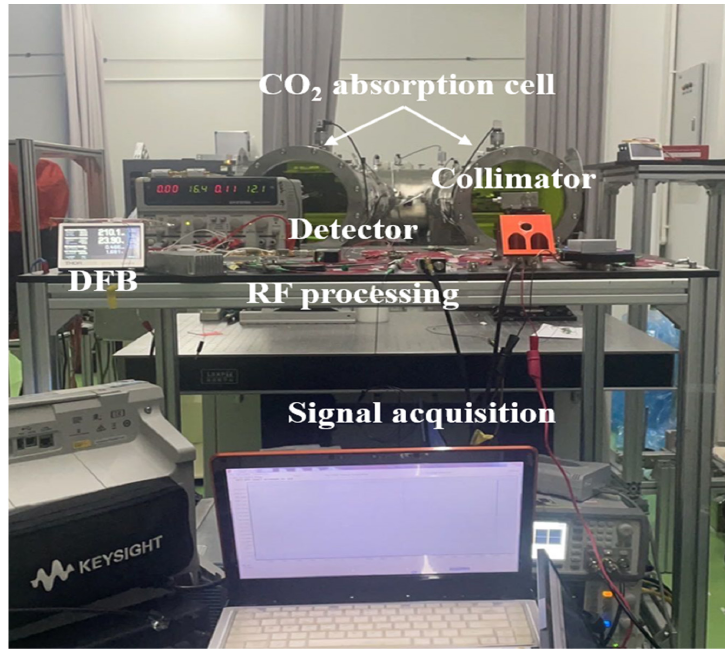
Figure 10. Diagram of experimental device. Table 7. The pressure in the absorption cell and the corresponding XCO 2 .